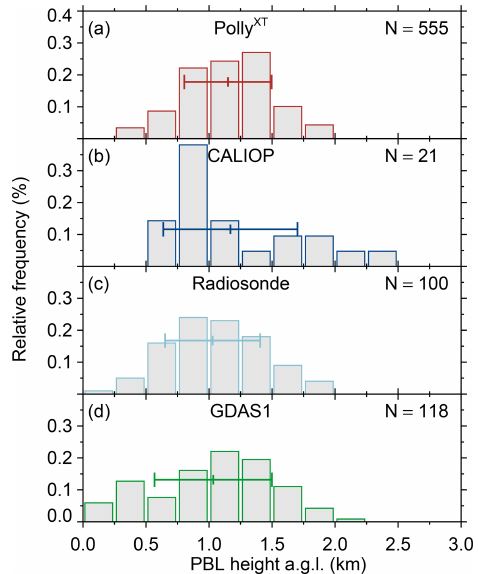
Figure 13. Frequency distribution of the PBL heights determined by (a) Polly XT between 4 December 2009 and 31 March 2010, (b) CALIOP between 1 May 2009 and 30 April 2010, (c) ra- diosonde (12:00UTC) and (d) GDAS1 data (12:00UTC) from 4 December 2009 to 31 March 2010 with an increment of 250m, respectively. N gives the number of samples. The horizontal error bar indicates the standard deviation.